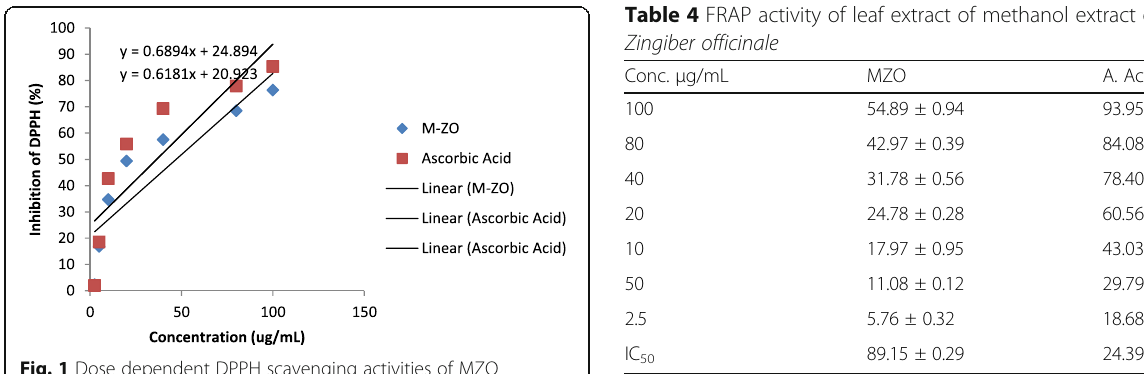
Values are mean±SEM of 3 determinations